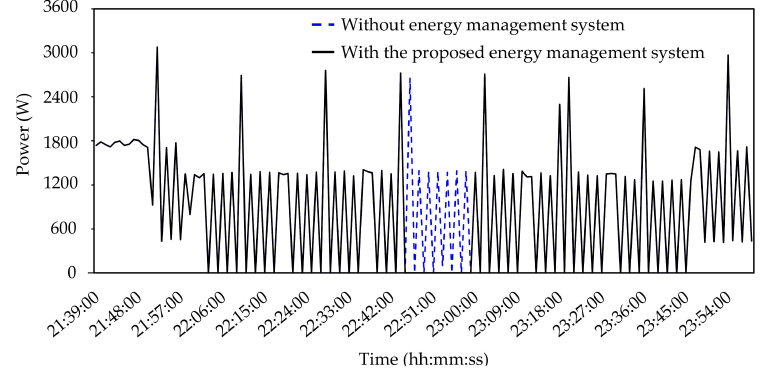
Figure 18. Example of electricity management of an electrical heater.